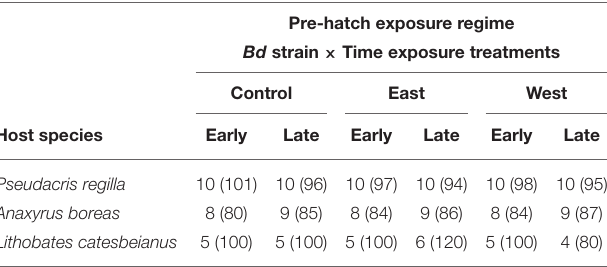
TABLE 1 | Number of replicates per treatment per species followed by total number of eggs per treatment between parentheses. Pre-hatch exposure regime